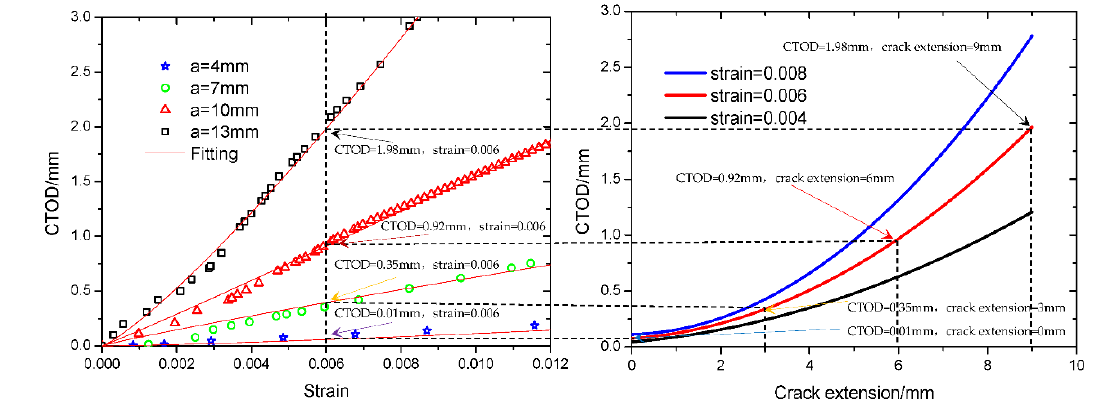
Figure 10. Crack growth driving force curves calculated using FEA results.